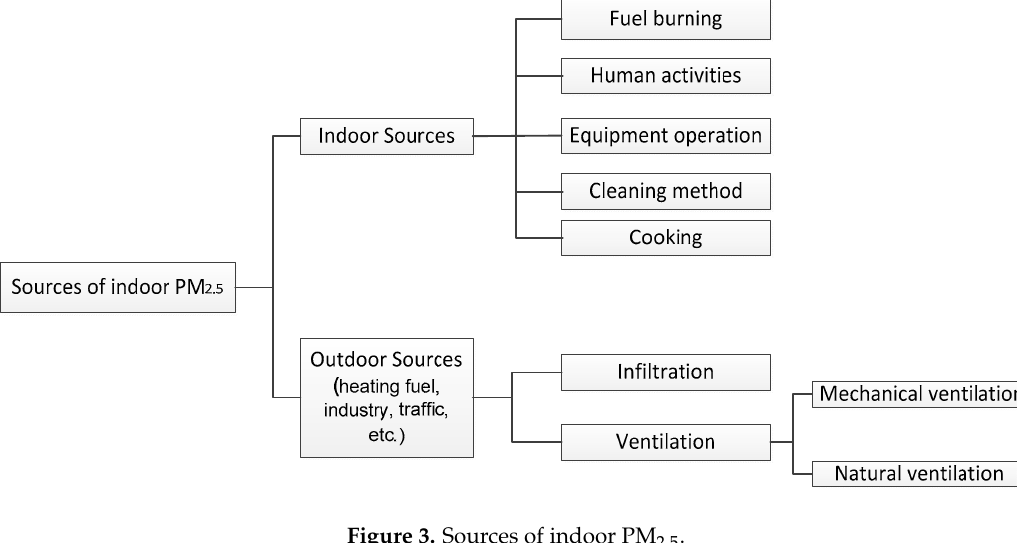
Figure 3. Sources of indoor PM 2.5 .